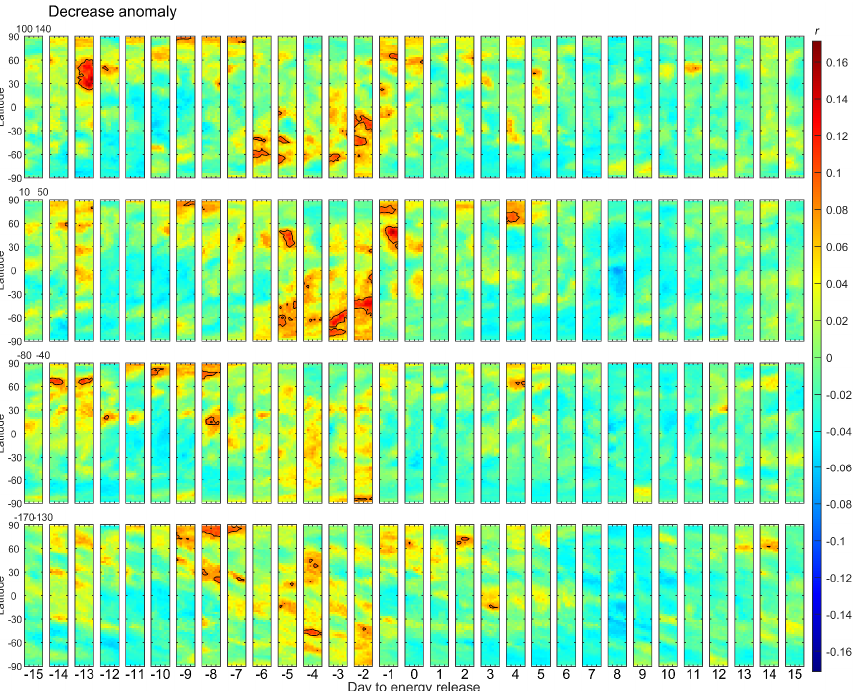
Figure 2. Temporal and spatial distributions of correlation coefficient between daily seismic wave energy release within 110–130°E and occurrence times of TEC decrease anomalies. Panels from left to right represent –15 to 15 days from the seismic wave energy release (D). Top to bottom panels display four selected longitude sectors centered over 120, 30, –60, and –150°E, respectively, each with a width of ±20°. The x-axis of each panel denotes the 40° longitude range, and the y-axis denotes latitude. The contour denotes r α = 0 . 01 = ±0.086.